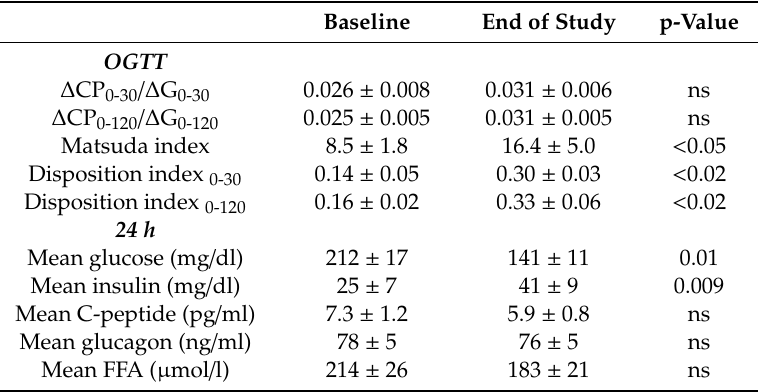
Table 3. Parameters of insulin secretion and insulin